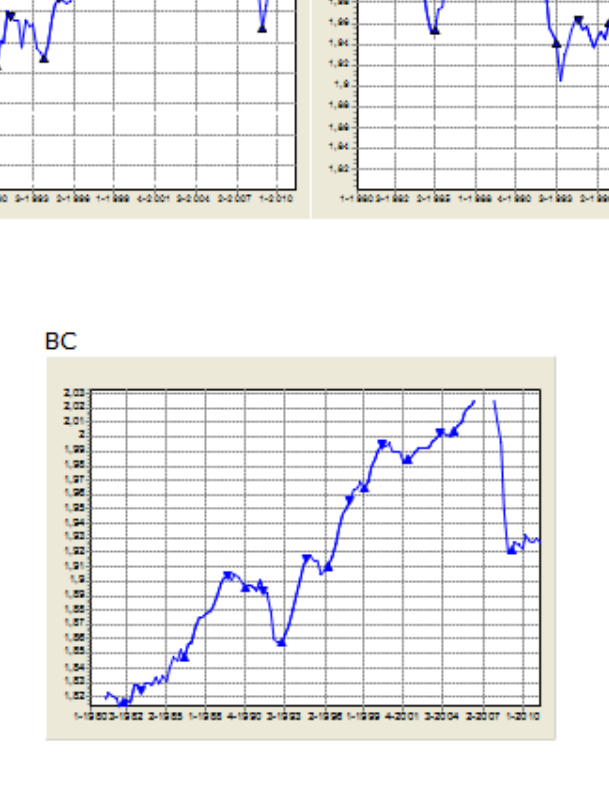
Journal of Industrial Engineering and Management, 2014